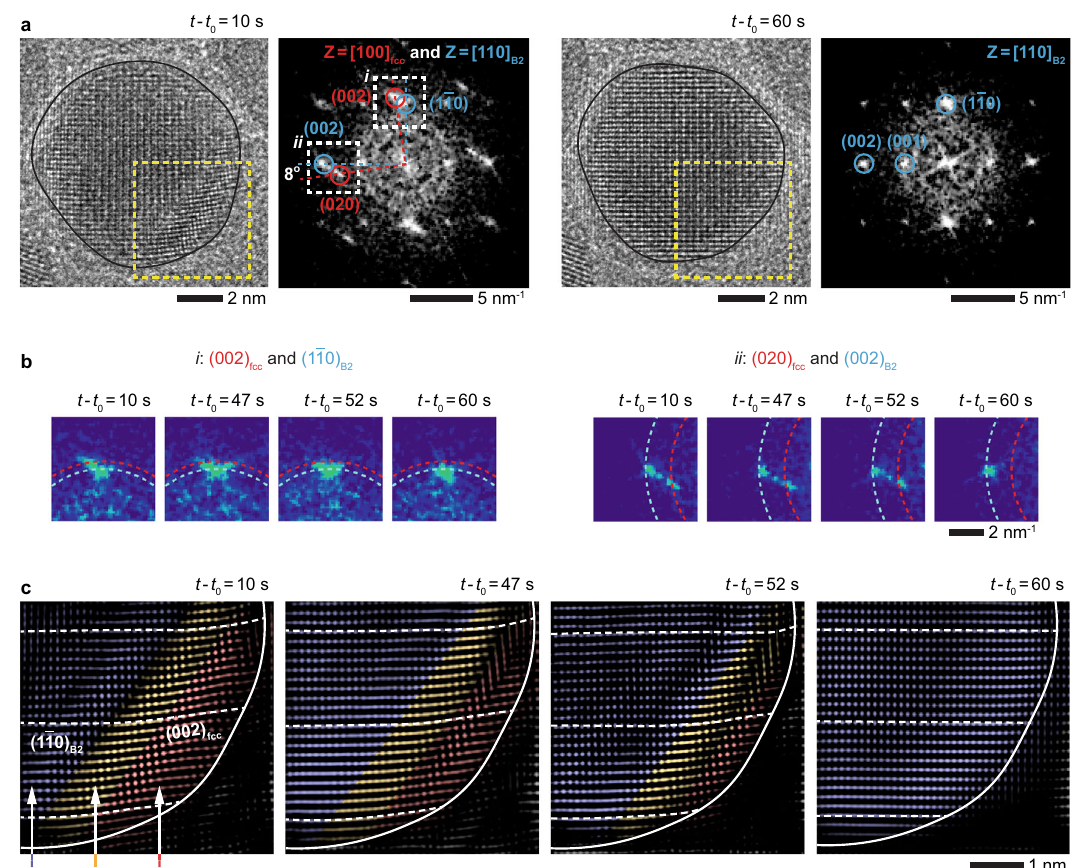
Fig. 2 | Structure and dynamics of fcc − B2 interface. a TEM and FFT images (from the dashed yellow boxes) showing the movement of the interface in the NP from the dashed yellow boxes in a showing the movement of the fcc − B2 interface ( t − t 0 =10s) asitconverts into a B2PdCu alloyNP( t − t 0 =60s) at500°C. b The two (Supplementary Movie 4). (see Supplementary Fig. 7a for the unprocessed TEM enlarged views marked (with dashed white boxes) in a showing the trace features (cid:1) (cid:3) images). The fcc, B2, and interface regions are false-colored in red, blue, and − 002 ð Þ connectingfccandB2spots( 002 ð Þ fcc − 1 (cid:1) 10 B 2 spots) B 2 spotsand 020 ð Þ fcc orange, respectively. The dashed white lines areguides showing how 002 ð Þ fcc and (cid:1) (cid:3) during the phase transition. The dashed red and blue arcs correspond to the 1 (cid:1) 10 B 2 planes connect via the interface. t 0 is the timepoint at which we started reciprocals of fcc and B2 lattice spacings, respectively (i.e., k 200 f g =5 : 3 nm − 1 , recording the fcc